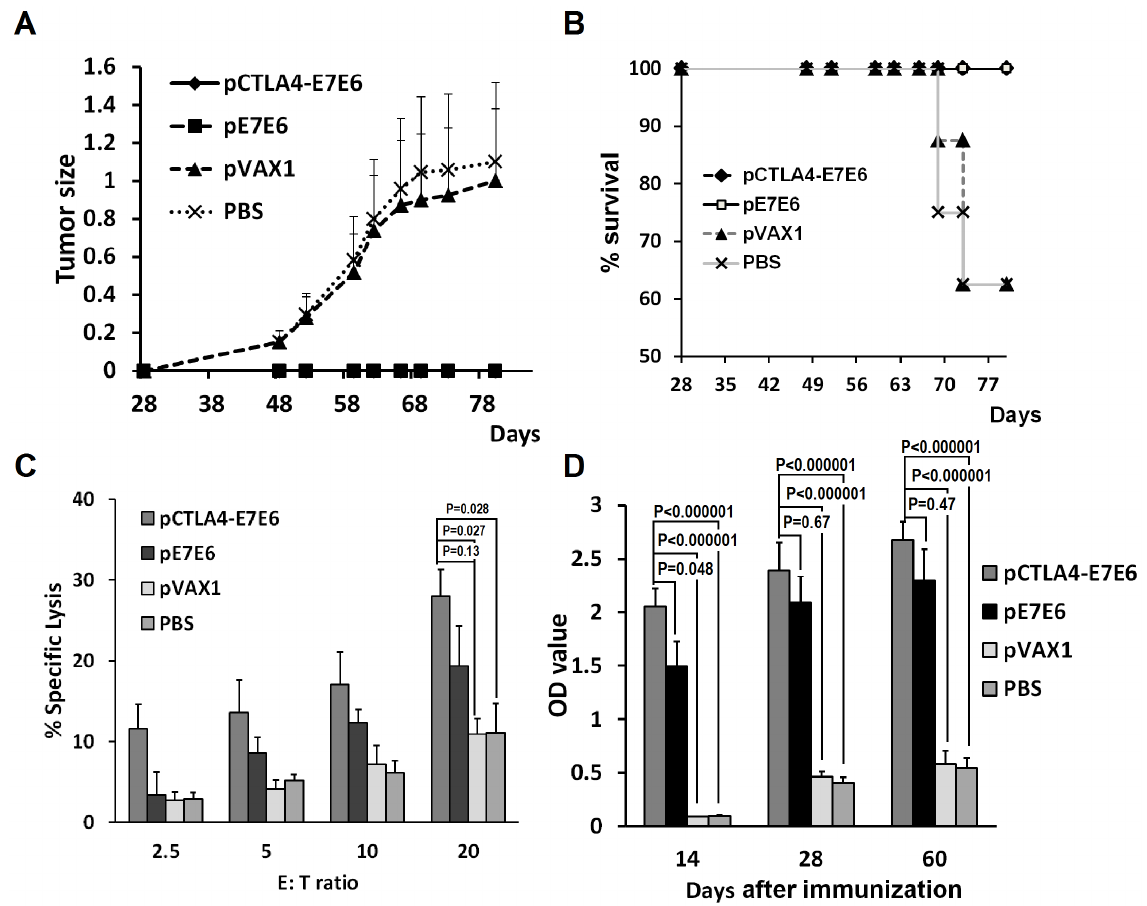
Figure 5. Anti-tumor preventive efficacy of pCTLA4-E7E6. ( A ) Effects on tumor growth by preventive vaccination. Mice were vaccinated with pCTLA4-E7E6, pE7E6, pVAX1 or PBS twice on day 0 and 14. On day 28 mice were challenged with 6 6 10 4 TC-1 tumor cells. Tumor size was recorded twice or thrice a week. ( B ) Kaplan-Meier survival analysis of mice survival in different groups. ( C ) Tumor specific CTL responses. Spleen cells were collected from alive mice in different groups on day 80 and used as effector (E) cells. TC-1 cells were used as target (T) cells. The cellular immune response against E7E6 was determined by lactate dehydrogenase (LDH) release assay. Various E/T ratios were tested as indicated. The data were presented as means 6 SE. ( D ) The levels of specific anti-E7E6 serum IgG were determined by ELISA assay on day 14, 28, and 60. The antibody levels of each group were presented as mean OD values 6 SE.